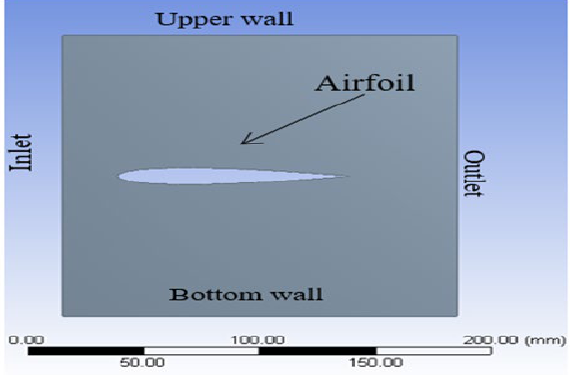
Figure 4. Geometry of NACA0012 at α=0 °